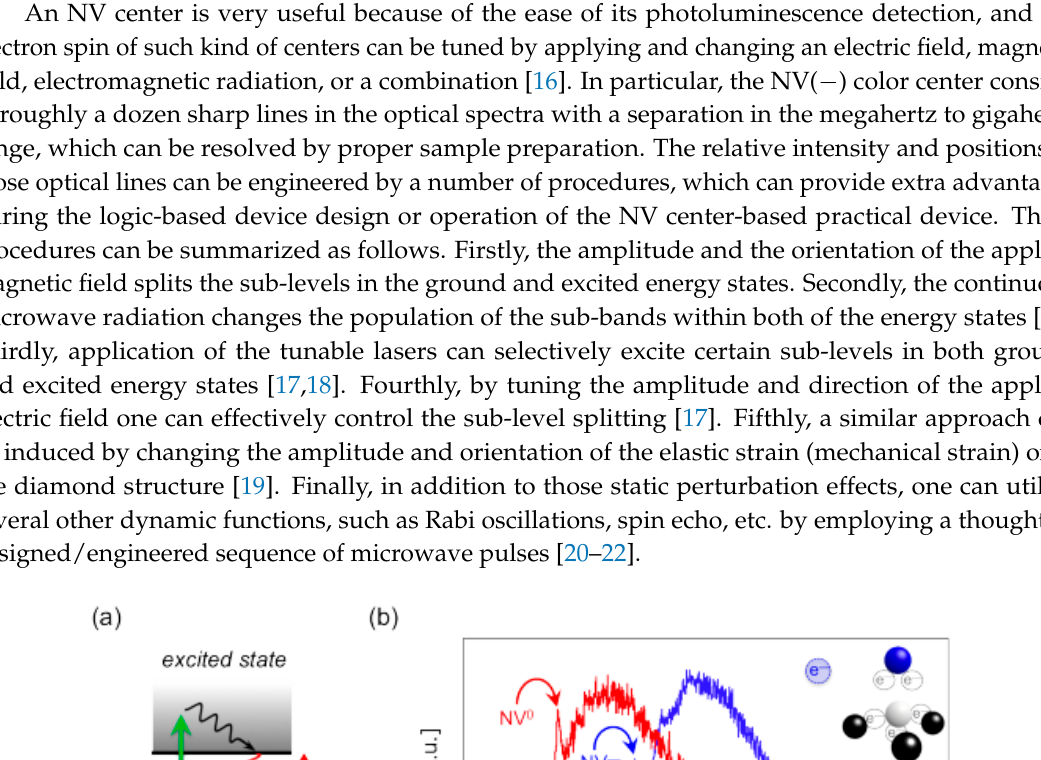
Figure 1. Schematic of ( a ) NV(0) center and ( b ) NV( − ) center in a diamond unit cell. NV: nitrogen-vacancy.